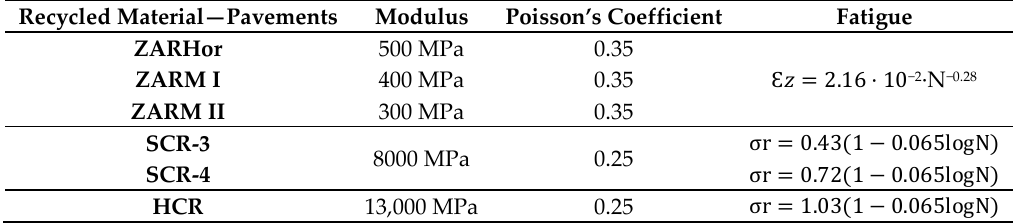
Table 2. Characteristics of the materials and fatigue laws.